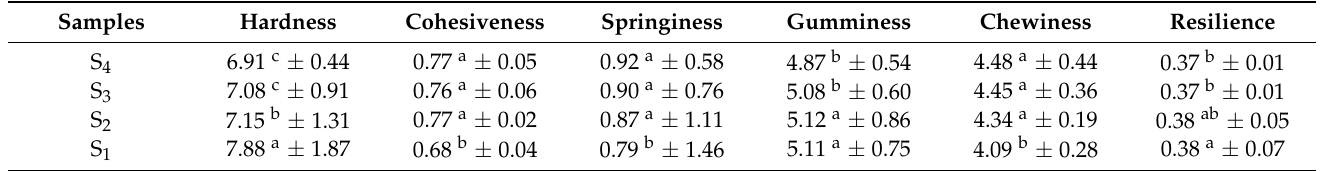
Table 5. Effect of addition of Aloe Vera leaf powder (ALP) on textural properties plain cakes. Samples